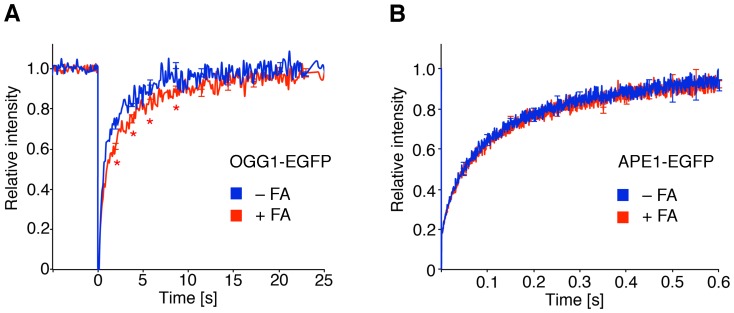
Formaldehyde-induced damage delays the nuclear trafficking of a DNA glycosylase.(A) Nuclear dynamics of OGG1, the DNA glycosylase that removes 8-oxo-dG, in human fibroblasts. Cells were transfected with the OGG1-EGFP construct, incubated for 18 h with 75 μM formaldehyde and subjected to FRAP analysis (N = 50; error bars, S.E.M.). The resulting fluorescence recovery curves were compared to those of untreated controls (*p<0.05). (B) FRAP studies (N = 50) demonstrating that the extremely fast movements of the APE1-EGFP fusion are not affected by the 75-μM formaldehyde treatment.